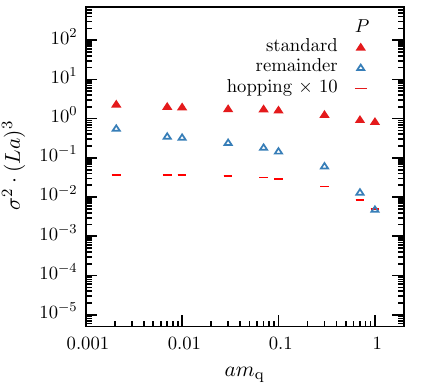
Fig. 2 Variances of the random-noise estimators τ R blue symbols) for the pseudoscalar density (left) and the vector current (right) as a function of the number of random sources N s for the ensem- ble F7, n = 2, and a bare quark mass of am q , r = 0 . 3. For comparison